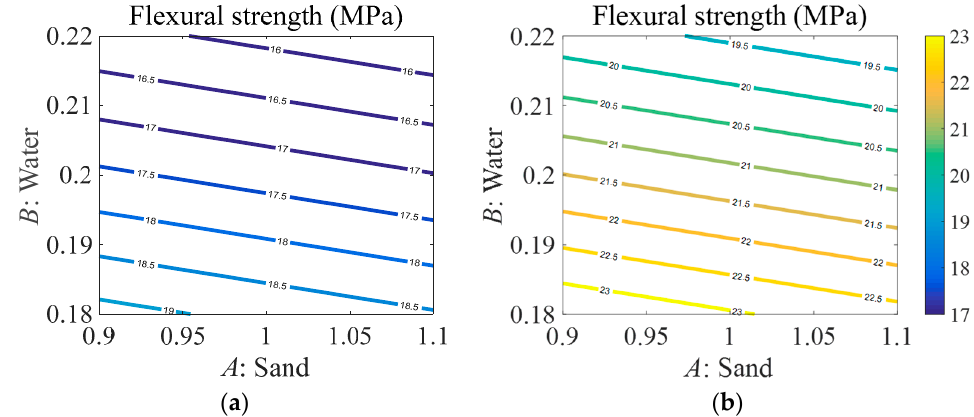
Figure 4. Contour plots of the s / b ratio ( A ) and w / b ratio ( B ) on flexural strength. ( a ) C = 0.225, D = 0.4 and ( b ) C = 0.3, D = 0.2.